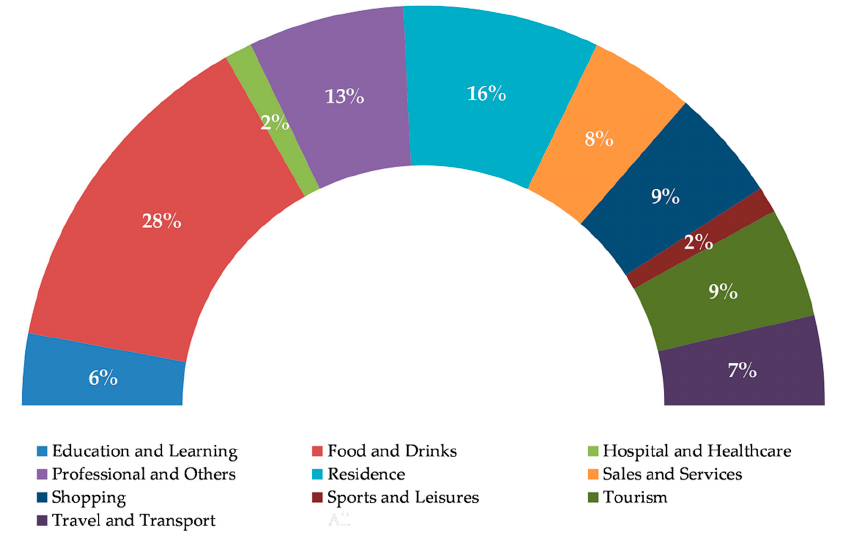
Figure 4. Check-in distribution of activities in Shanghai.